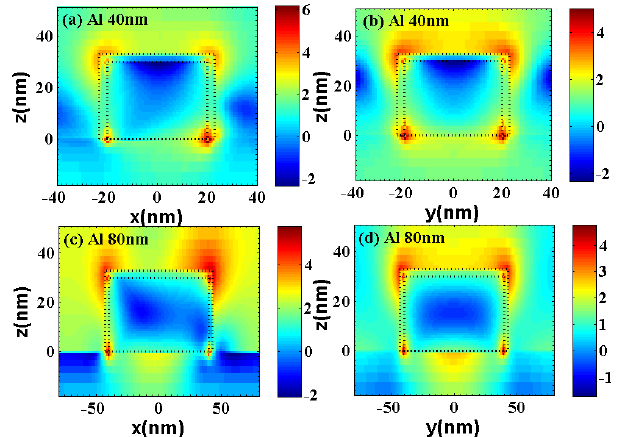
Figure 4. The steady-state electric field intensity distribution of p-polarization in the ( a , c ) x-z plane and ( b , d ) y-z plane at ( θ = 24 ◦ , λ = 291 nm) for SP-LEDs with 40 nm or 80 nm Al